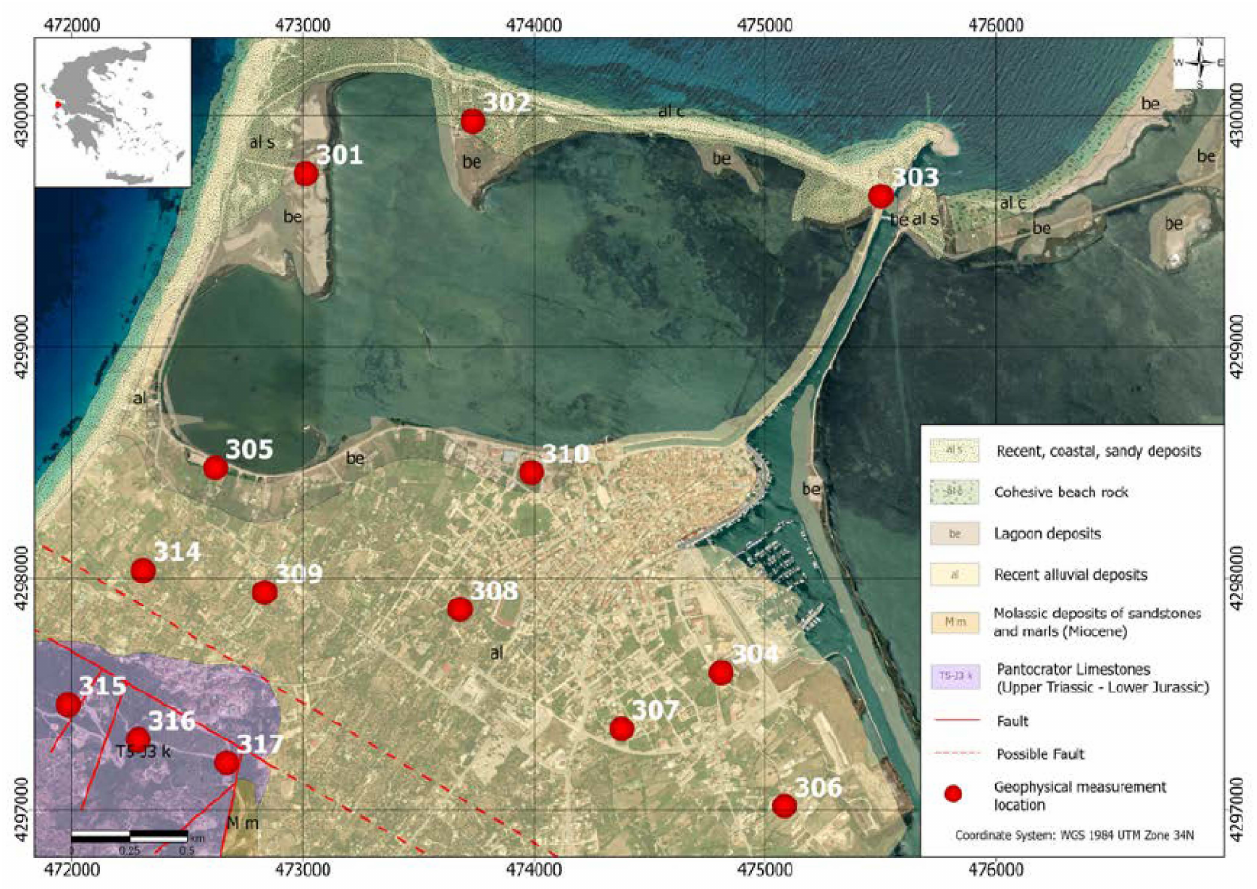
Figure 2. Modified geological map of Lefkada town